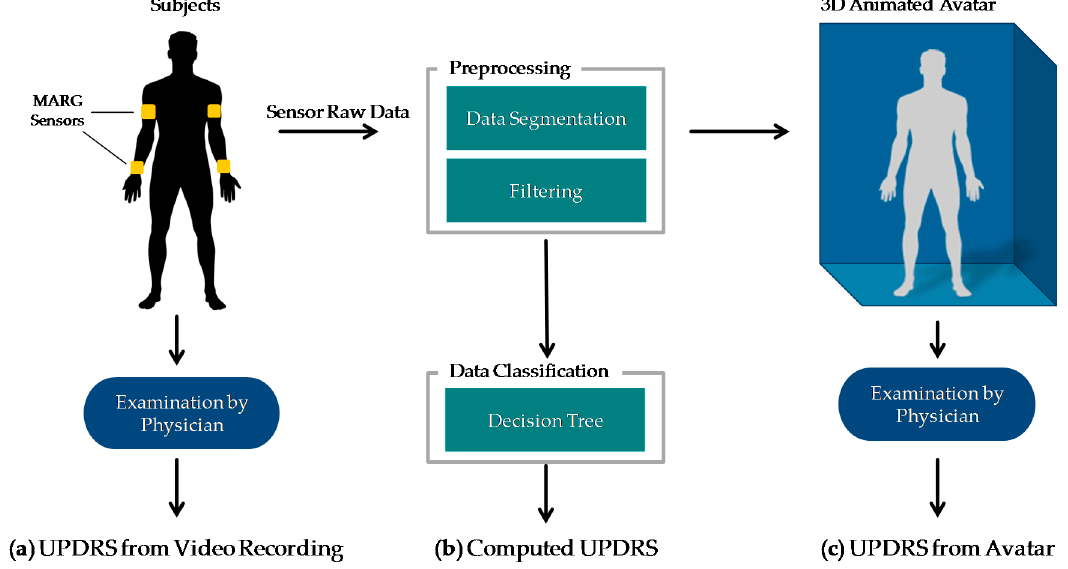
Figure 1. Comparison of UPDRS ratings based on ( a ) Video recordings; ( b ) Automated classification algorithm; ( c ) Animated 3D avatar.